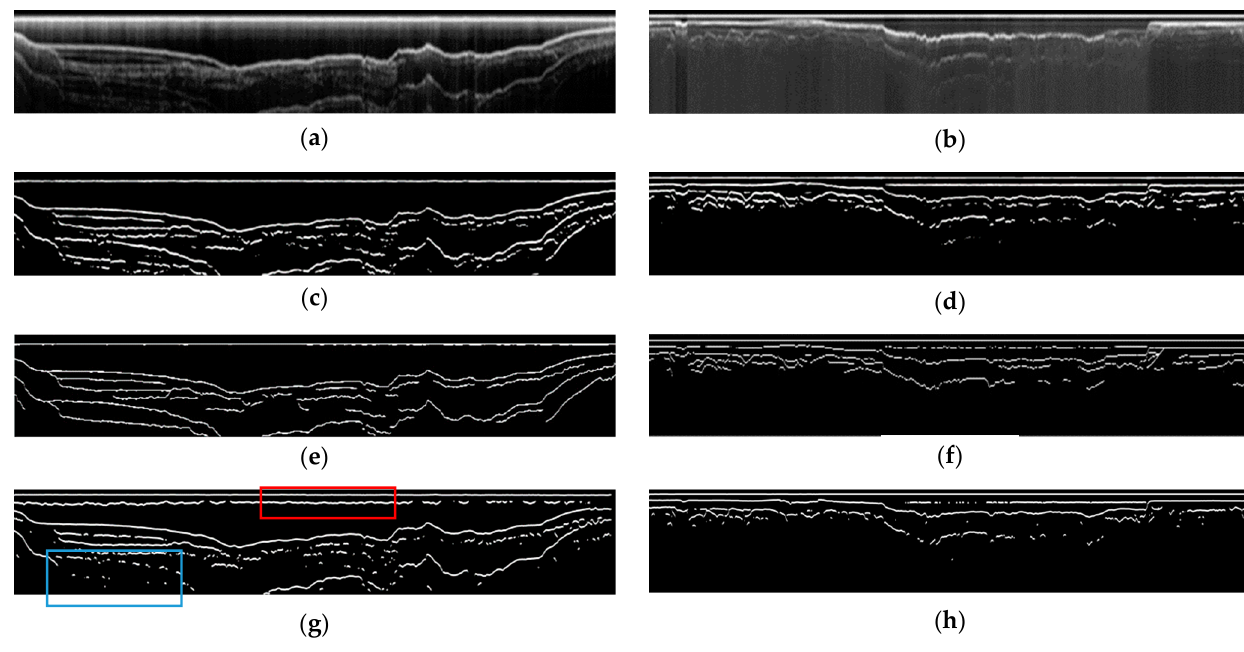
Figure 16. The identified horizons and multiples. In ( a , b ), the test inputs, are the raw SBP images numbered SBL_20120628_085229 and SBL_20160305_025613, respectively. In ( c , d ) are the predictions of ( a , b ), respectively. The predictions are binary images and contain the identified multiples and horizons. In ( e , f ) are the identified multiples and horizons by visual interpretation for ( a , b ), respectively. In ( g , h ) are the identified multiples and horizons by the FrangiV algorithm for ( a , b ), respectively. The horizons in the red rectangle are false, and the horizons discontinuity in the blue rectangle is true.